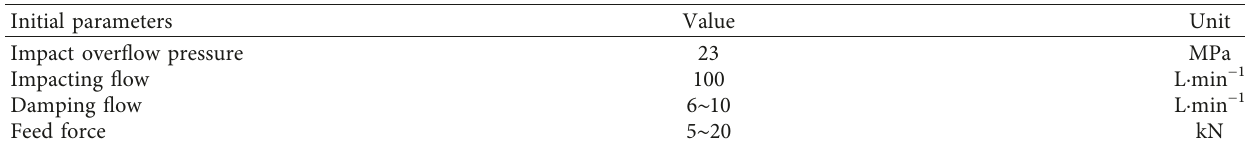
Figure 4: Impact and damping systems’ test principle. (1) Computer; (2) data acquisition system; (3) signal amplifier; (4) punching cylinder; (5) drill rod; (6) hydraulic rock drill; (7) feed cylinder; (8) hydraulic pumping station. Table 1: Initial data setting for experiments.